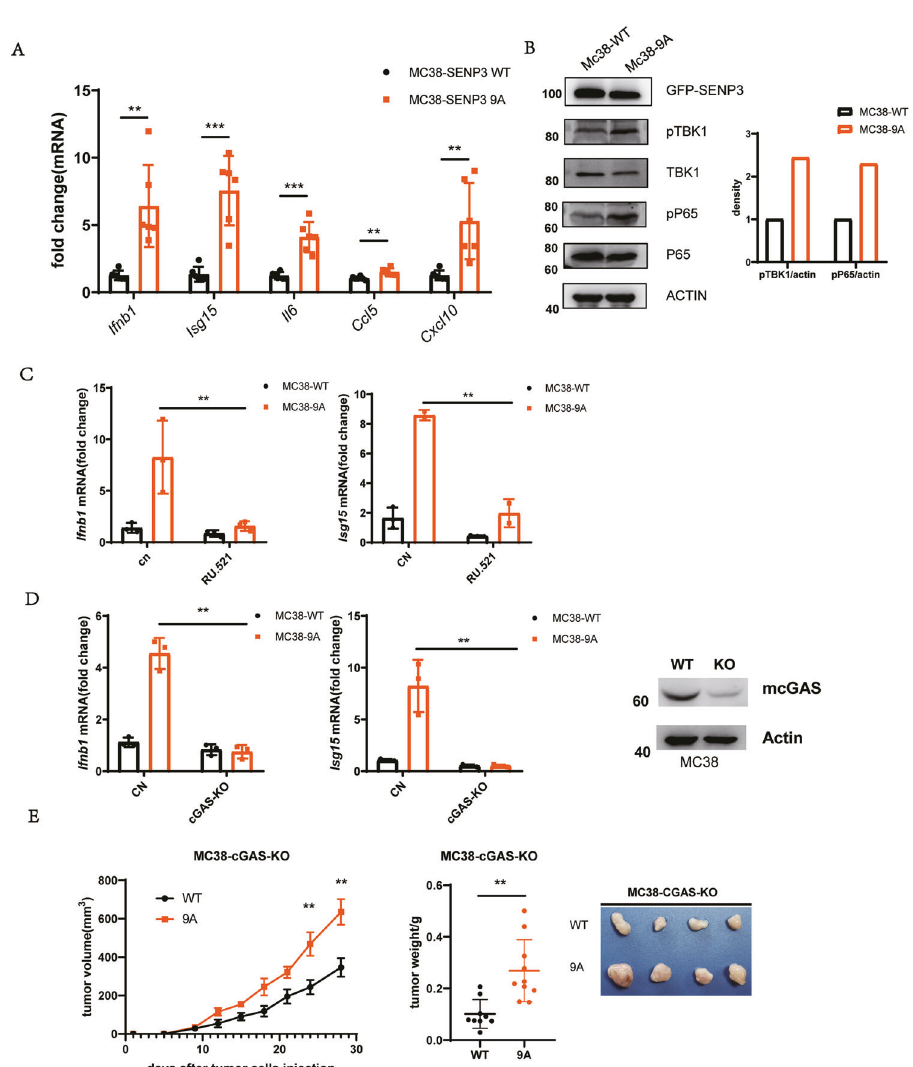
Fig. 2 Mitotic SENP3 activates cGAS signaling. A Real-time PCR was used for the analysis of Ifnb1, Isg15, Il6, Ccl5 , and Cxcl10 expression in SENP3-WT-MC38 cells (WT) or SENP3 – 9A-MC38(9A) cells. The data were normalized to Gapdh internal control and represented as mean with SD ( n = 3 independent biological replicates). ** p < 0.01, *** p < 0.001. B Cell lysates from SENP3-WT-MC38 cells (WT) or SENP3 – 9A-MC38(9A) cells were blotted with anti-SENP3, anti-phosph-TBK1(pTPK1), anti-TBK1, anti-phosph-P65(pP65), anti-P65, or anti-actin antibodies. C Real-time PCR was used for analysis of Ifnb1 and Isg15 expression in SENP3-WT-MC38 cells (WT) or SENP3 – 9A-MC38(9A) cells treated with or without RU.521 for 2 days. The data were normalized to Gapdh internal control and represented as mean with SD ( n = 3 independent biological replicates). ** p < 0.01. D cGAS in SENP3-WT-MC38 cells (WT) or SENP3 – 9A-MC38(9A) cells was knocked out by using Cas9/CRISPER system plasmid px459 encoding cGAS gRNAs (left panel). Real-time PCR was used for the analysis of Ifnb1 and Isg15 expression in these cells. The